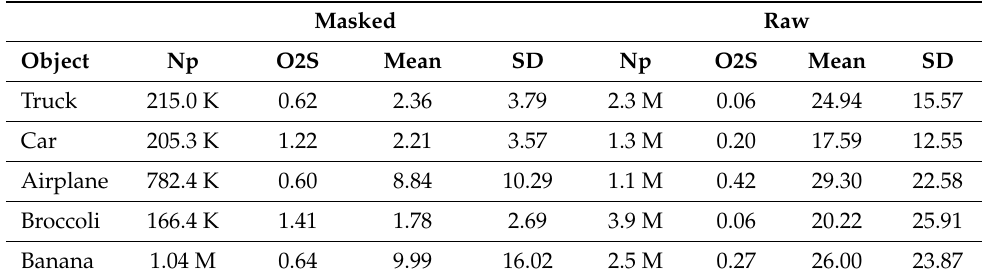
Table 5. Agisoft masked and raw point clouds mean and standard deviation distances relative to reference point cloud in